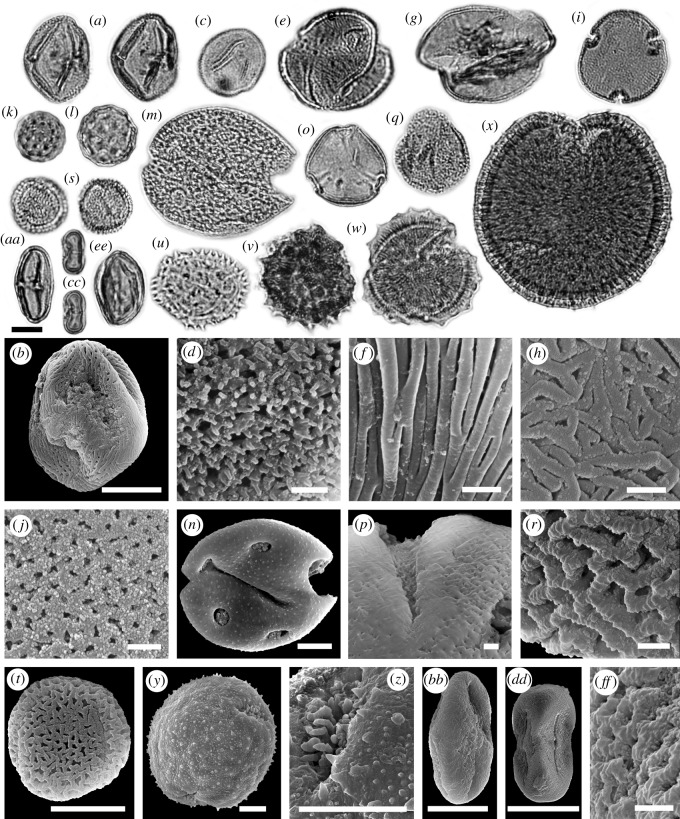
LM and SEM micrographs of Sapindales, Malvales, Caryophyllales, Cornales, Asterales, Dipsacales, and Apiales. (a,b) Cotinus sp., EV. (c,d) Pistacia sp., (c) PV, (d) exine SEM detail. (e,f) Acer sp. 1, (e) PV, (f) mesocolpium SEM detail. (g,h) Acer sp. 2, (g) PV, (h) mesocolpium SEM detail. (i,j) Craigia sp., (i) PV, (j) apocolpium SEM detail. (k) Amaranthaceae/Chenopodioideae gen. indet. sp. 1. (l) Amaranthaceae/Chenopodioideae gen. indet. sp. 2. (m,n) Caryophyllaceae gen. indet. (o,p) Nyssa sp., (o) PV, (p) exine sculpturing and aperture SEM detail. (q,r) Fraxinus sp., (q) EV, (r) mesocolpium SEM detail. (s,t) Olea sp., EV. (u) Cichorioideae gen. indet., PV. (v) Asteraceae gen indet. sp. 1, PV. (w) Asteraceae gen indet. sp. 2, PV. (x–z) Succisa sp., (x,y) PV, (z) aperture SEM detail. (aa–bb) Apiaceae gen. indet. sp. 1, EV. (cc–dd) Apiaceae gen. indet. sp. 2, EV. (ee–ff) Angiosperm pollen fam. et gen. indet., (ee) EV, (ff) mesocolpium SEM detail. Equatorial view (EV), polar view (PV). Scale bars 10 µm (LM, b,n,t,y,z,bb,dd), 1 µm (d,f,h,j,p,r,ff).